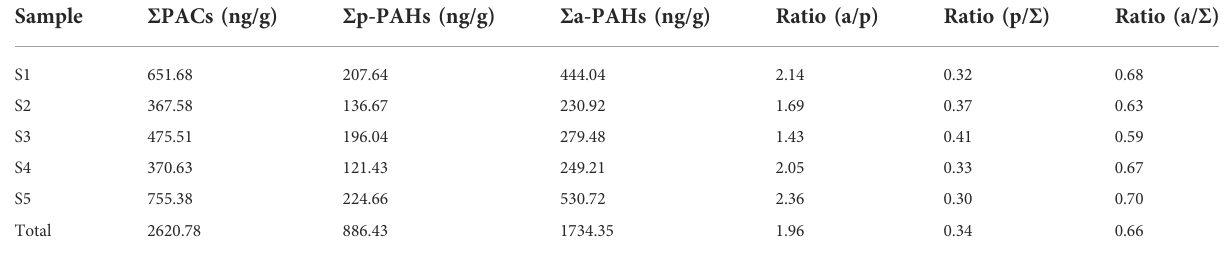
TABLE 4 Distribution and ration of different kinds of PAHs content in sampling